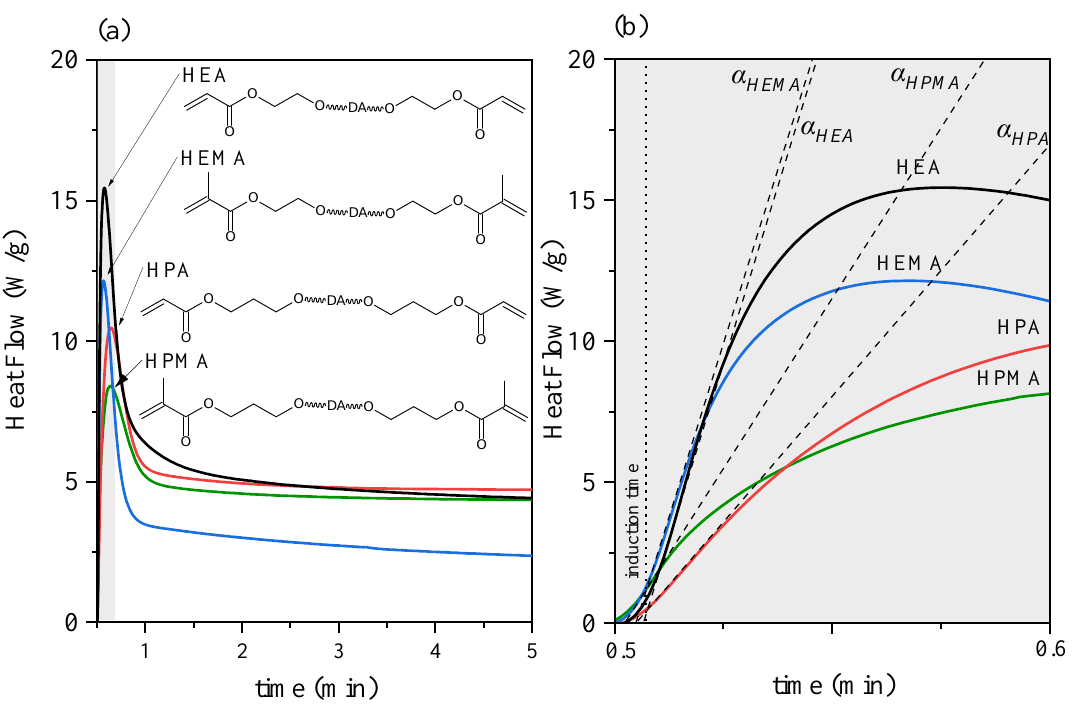
Figure 7. Photopolymerization process of obtained UA-DA resins monitored by photo-DSC; ( a )—Heat flow during UV exposure; ( b )—enlargement of a fragment of the Figure 7a. Table 2. Characteristics of the photocuring process of UA-DA resins.